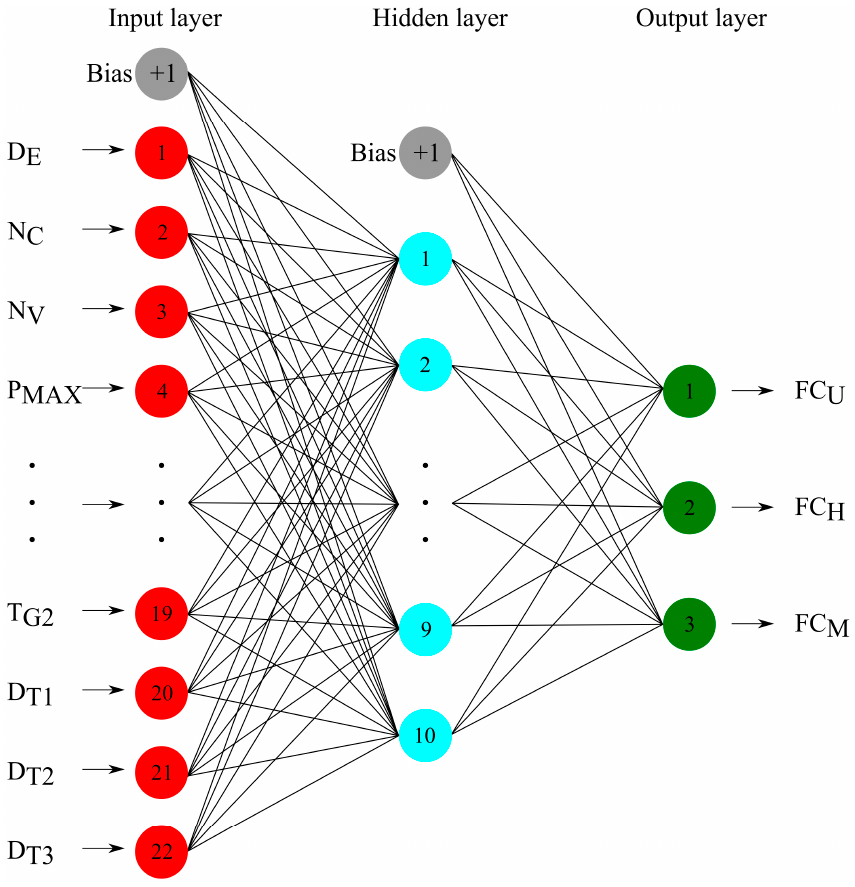
Figure 5. Simplified model of the MLP 22-10-3 artificial neural network.